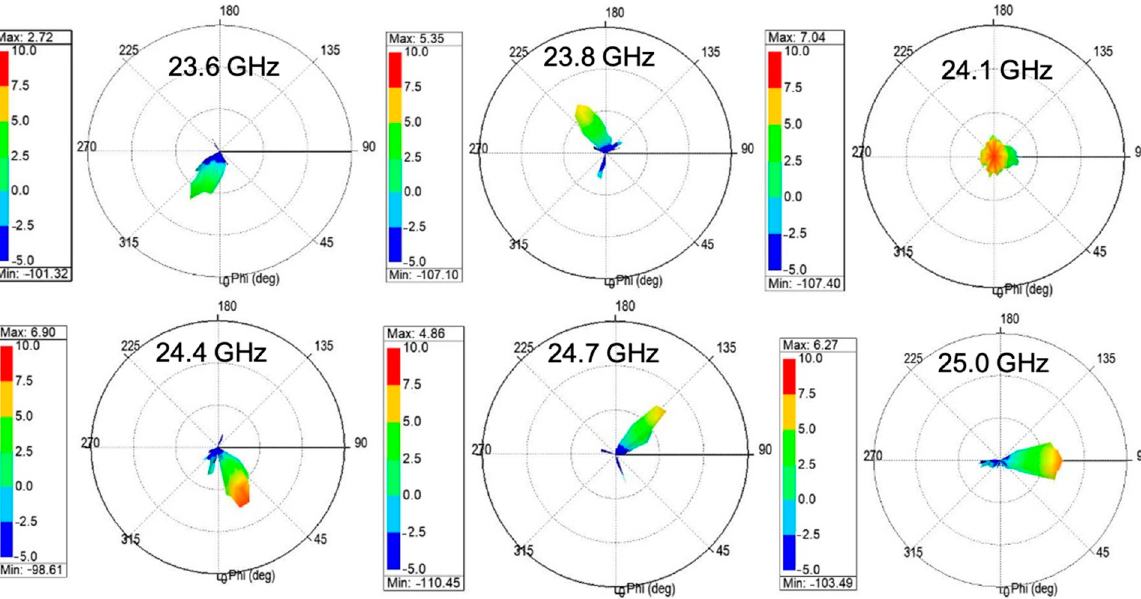
Figure 24. ( a ) Phase responses of the series feeding network; ( b ) S11 of 2D frequency-dependent beam scanning MTM LWA array [52].